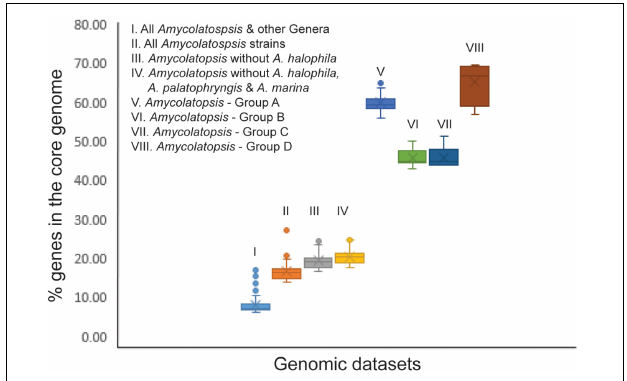
FIGURE 4 | A box plot showing the fraction of genes in the core genome for the different genomic